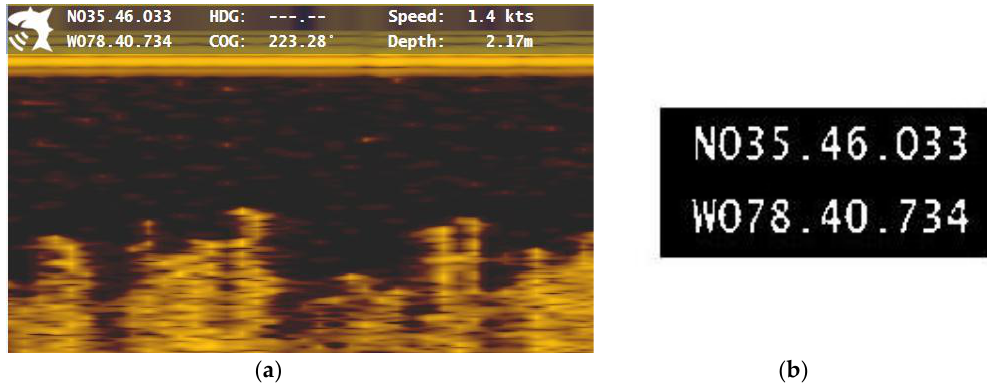
Figure 15. GPS coordinate extraction with image preprocessing: ( a ) raw/unprocessed hydroacoustic image and ( b ) preprocessed image optimized for optical character recognition (OCR). Generated output: N035 . 46.033 ↵ W078 . 40 . 734 ↵↵.